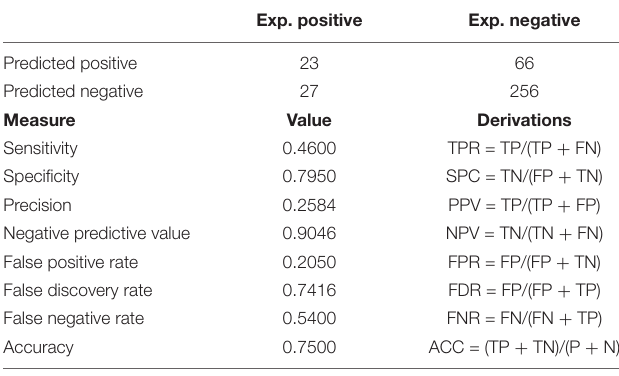
TABLE 6 | Confusion matrix and respective performance measure calculations of the iDS372 model in predicting essential genes. Exp. positive